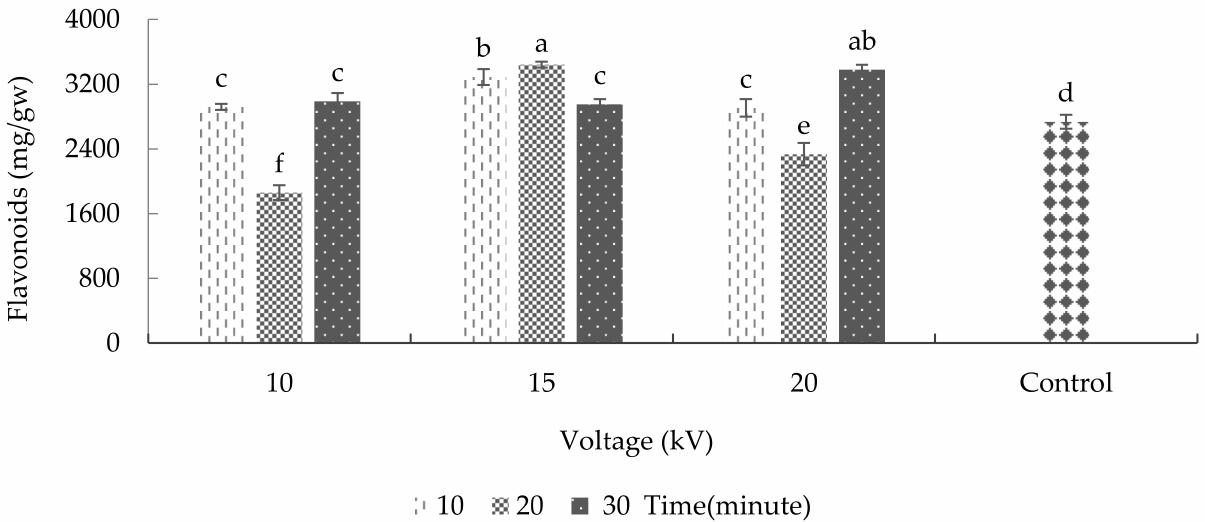
Figure 8. Plasma effect on the overall flavonoid of basil. Error bars indicate standard error ( n = 3). Different lowercase letters denote statistical differences between treatment groups at the 5% level according to Duncan’s